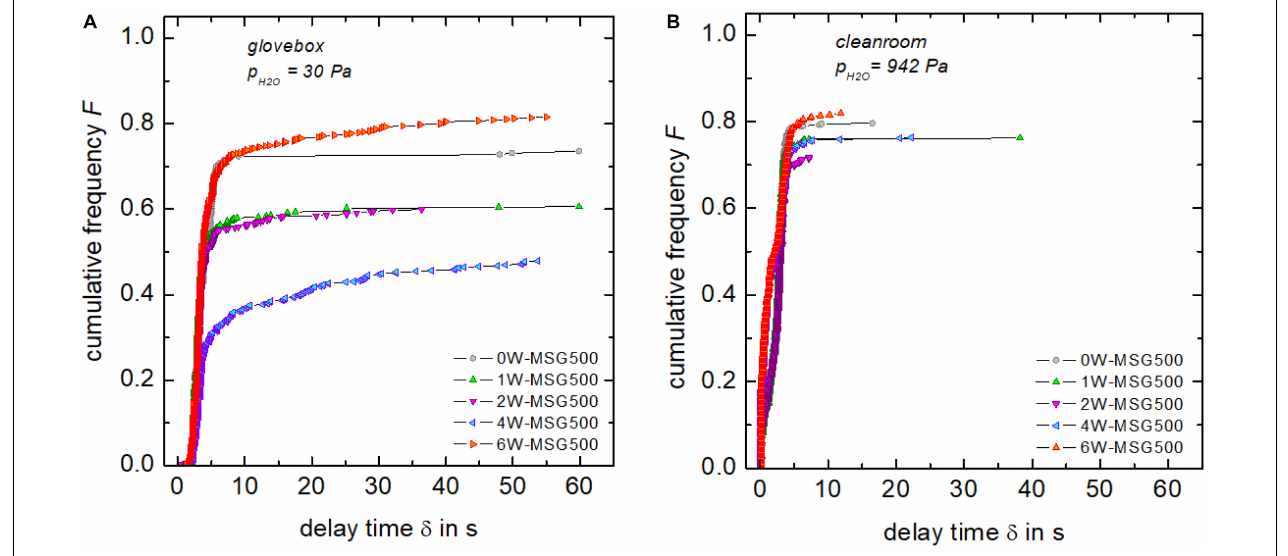
FIGURE 2 | Cumulative frequency distribution F ( δ ) of the number of initiated cracks tested in dry (A) and humid (B) environments. Lines connecting data points are intended as visual